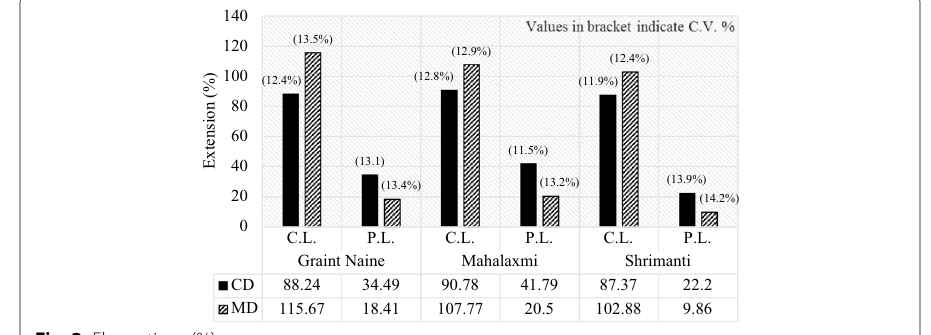
Fig. 3 Elongations (%)